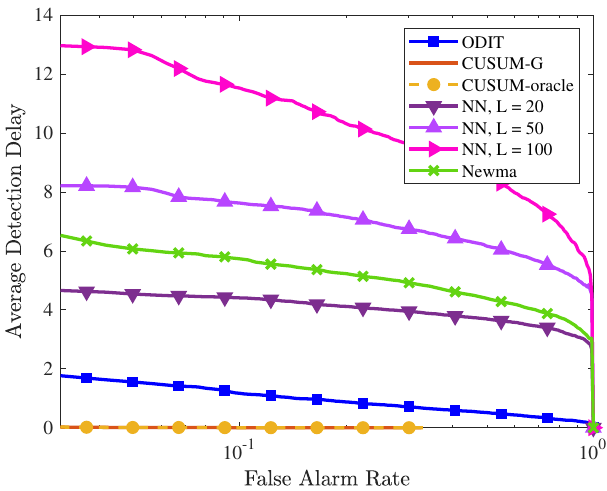
Figure 6. Performance comparison of the proposed ODIT, CUSUM, NN, and NEWMA detectors in the synthetic change-in-the-mean experiment in terms of average detection delay vs. FAR (in log-scale).